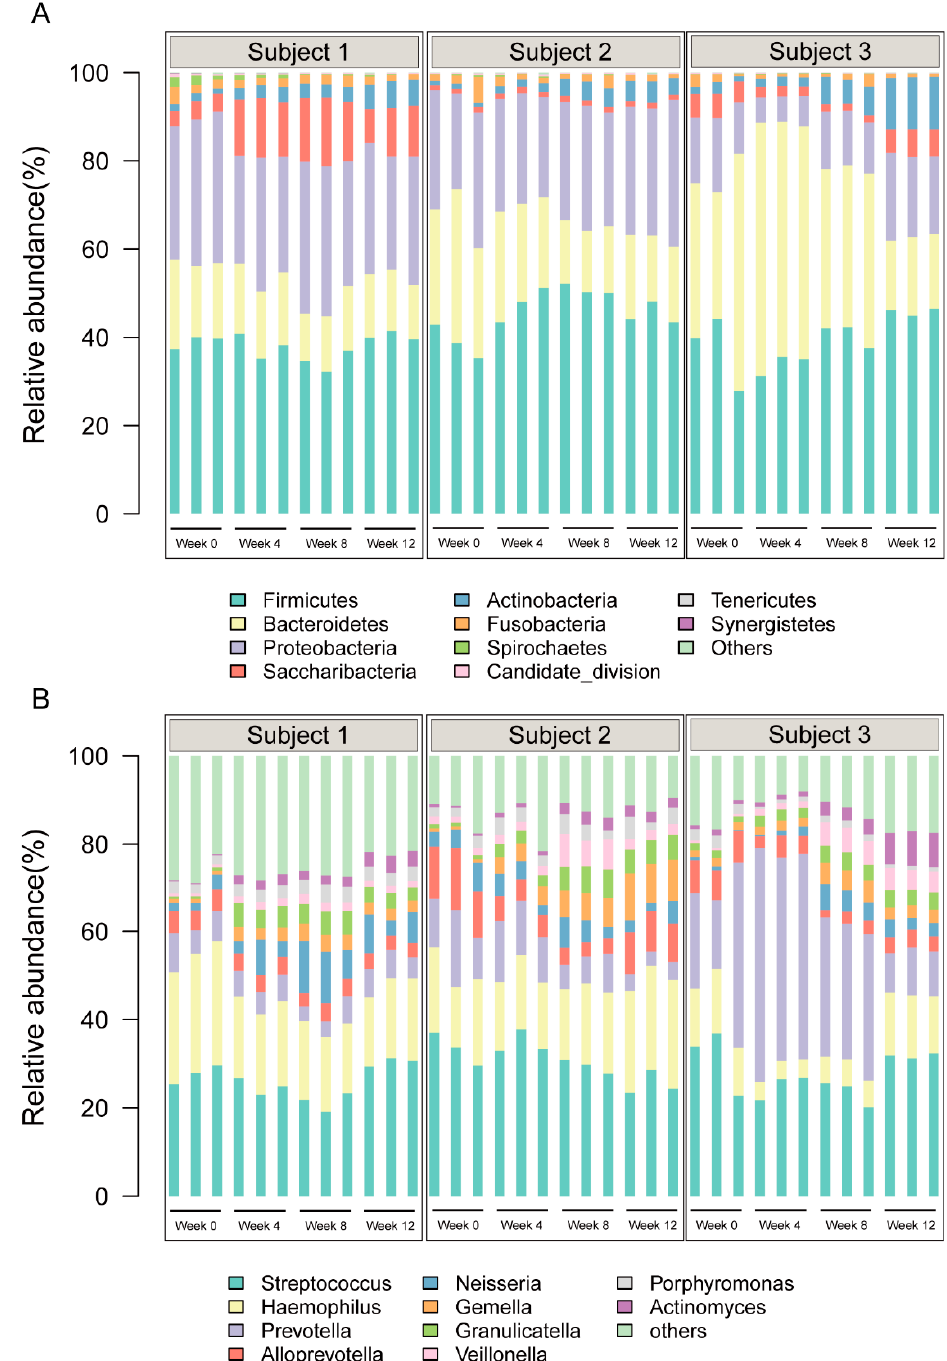
Figure 1. Relative abundances of the most abundant phyla and genera in each salivary sample in the ( A ) phylum level and ( B ) genus level. ( A ) phylum level and ( B ) genus